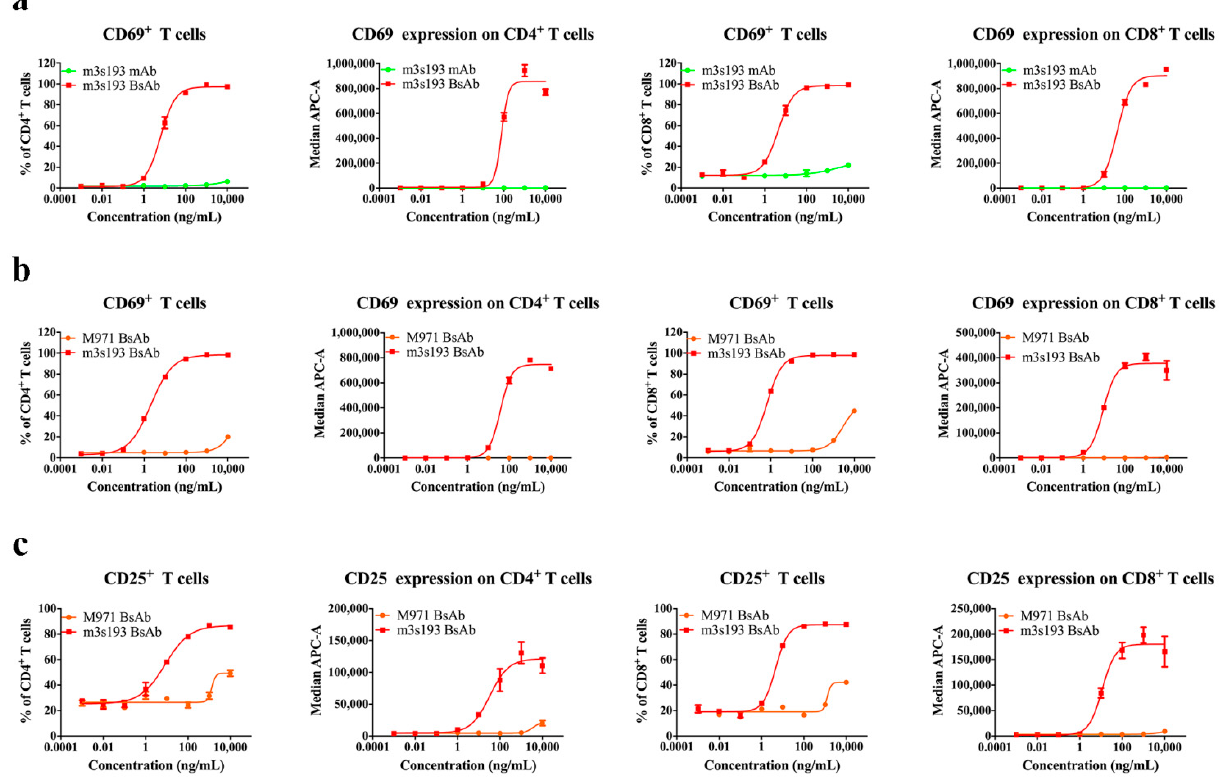
Figure 3. Activation of CD69 and CD25 expression on CD8 + and CD4 + T cells. The expression frequency and intensity of CD69 or CD25 on CD8 + and CD4 + T cells after 20 h ( a , b ) or 90 h ( c ) of co-incubation of NCI-N87 cells and huPBMCs. Data are shown as means ± SD with three duplicates.